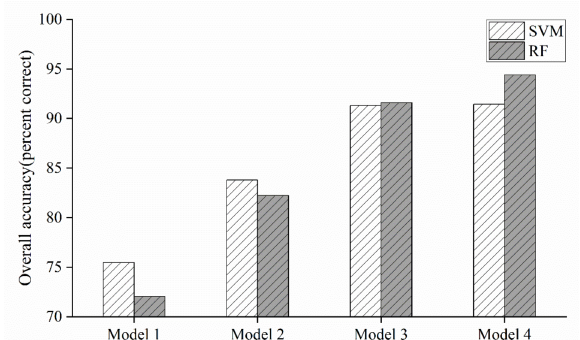
Figure 10. Comparison of the overall classification accuracies of the four object-based classification models obtained using two machine learning algorithms: support vector machine (SVM) and random forest (RF).